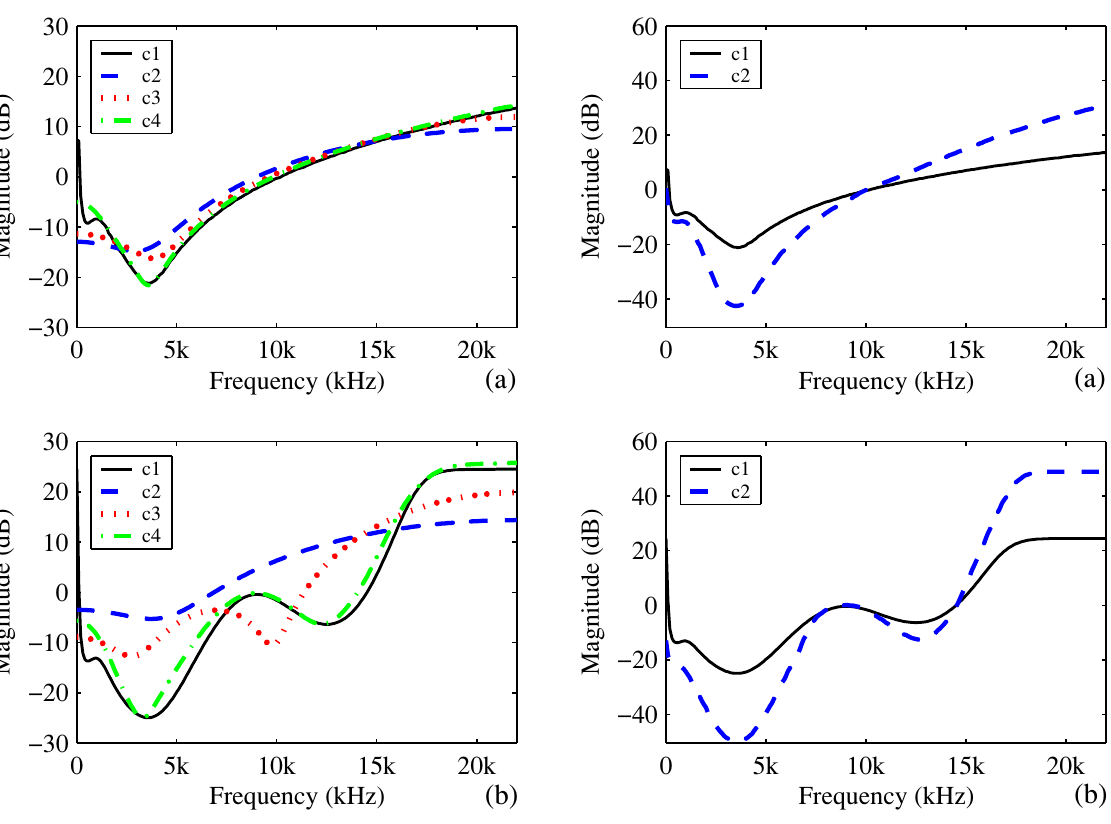
Figure 4. The design curves (modified E (a) and modified F (b)) (c1) and their new versions (new modified E (a) and new modified F (b))